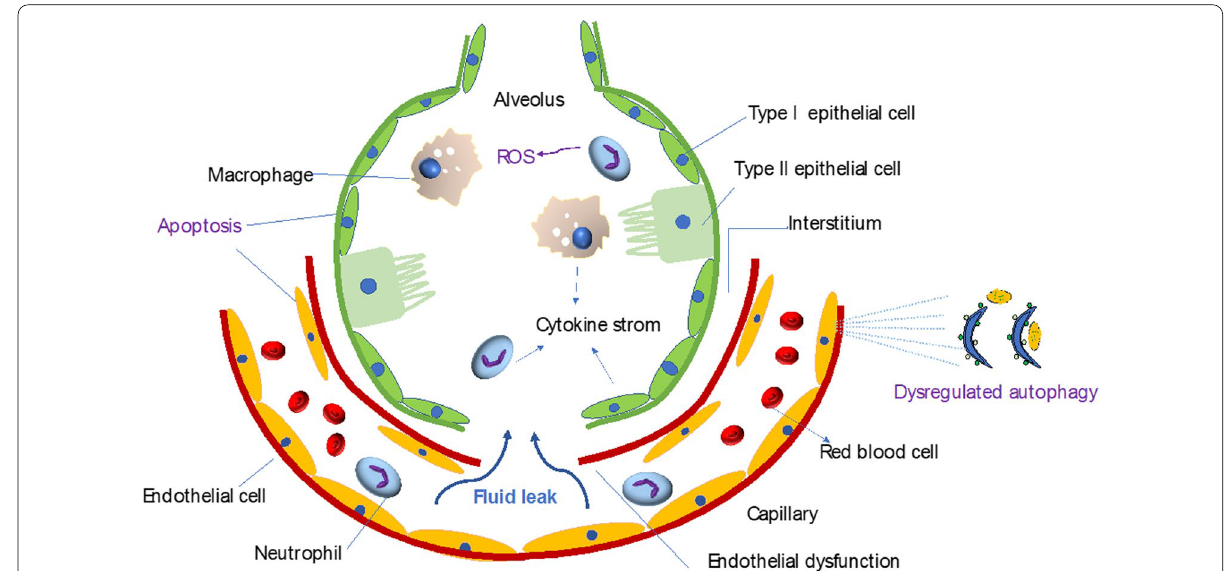
Fig. 1 The pathogenesis of acute lung injury involves dysregulated inflammation and alveolar and endothelial barrier